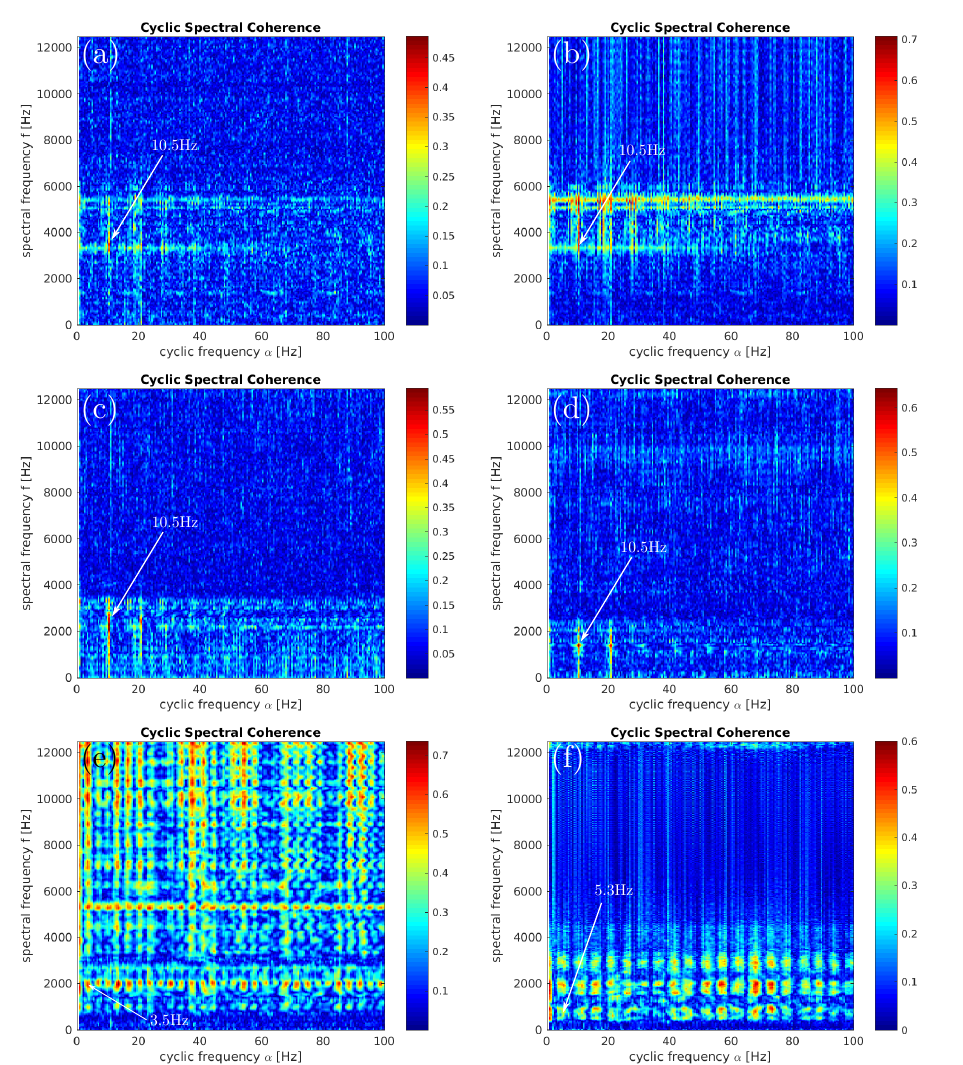
Figure 8. Cyclic Spectral Coherence of unbalanced condition. From left to right the top row shows the original signal and filtered signal using Wavelet Daubechies-3 (db3) filter. The middle row is the first and second IMFs and the bottom row is 6th and 8th